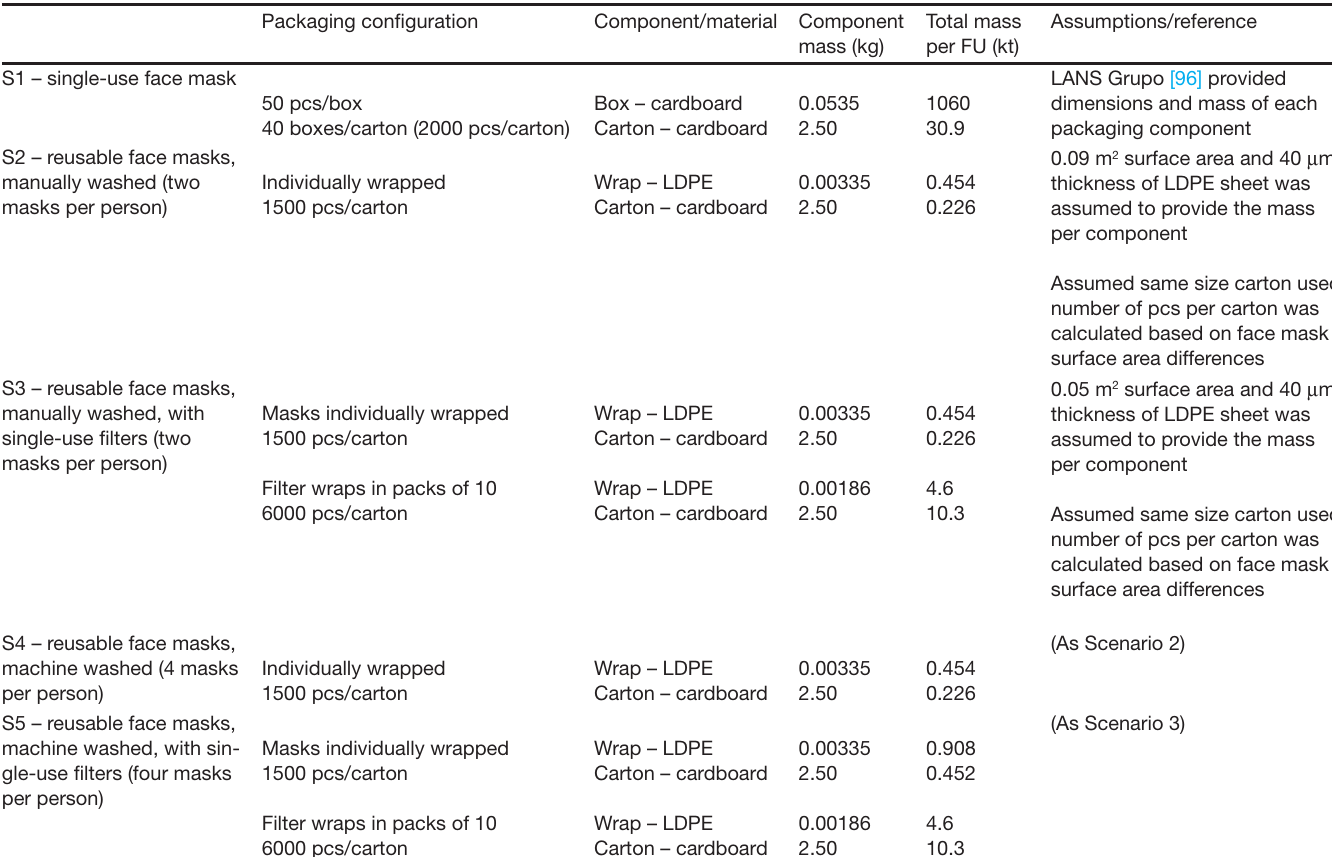
Table A6. Packaging assumptions for each scenario. Packaging configuration